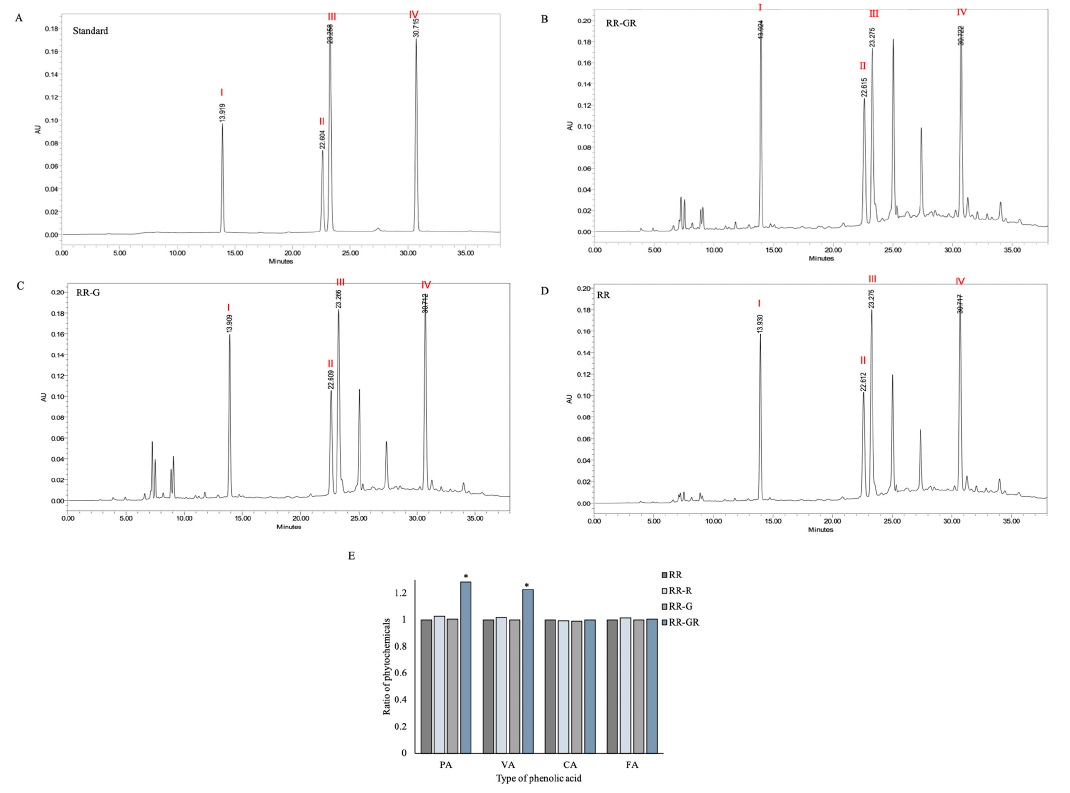
Figure 3. HPLC chromatogram of standard ( A ), riceberry rice with germination and radiation (RR-GR) ( B ), riceberry rice with germination (RR-G) ( C ), and riceberry rice (RR) ( D ). Percentage of area was presented in bar graph ( E ). The number represented in each type of phytochemicals I: protocatechuic acid (PA), II: vanillic acid (VA), III: caffeic acid (CA), IV: ferulic acid (FA). * Statistical significance at p < 0.05.